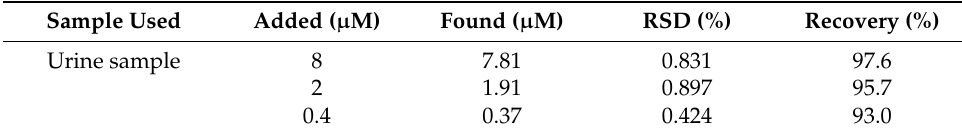
Table 1. Detection of dopamine (DA) in urine samples (n =